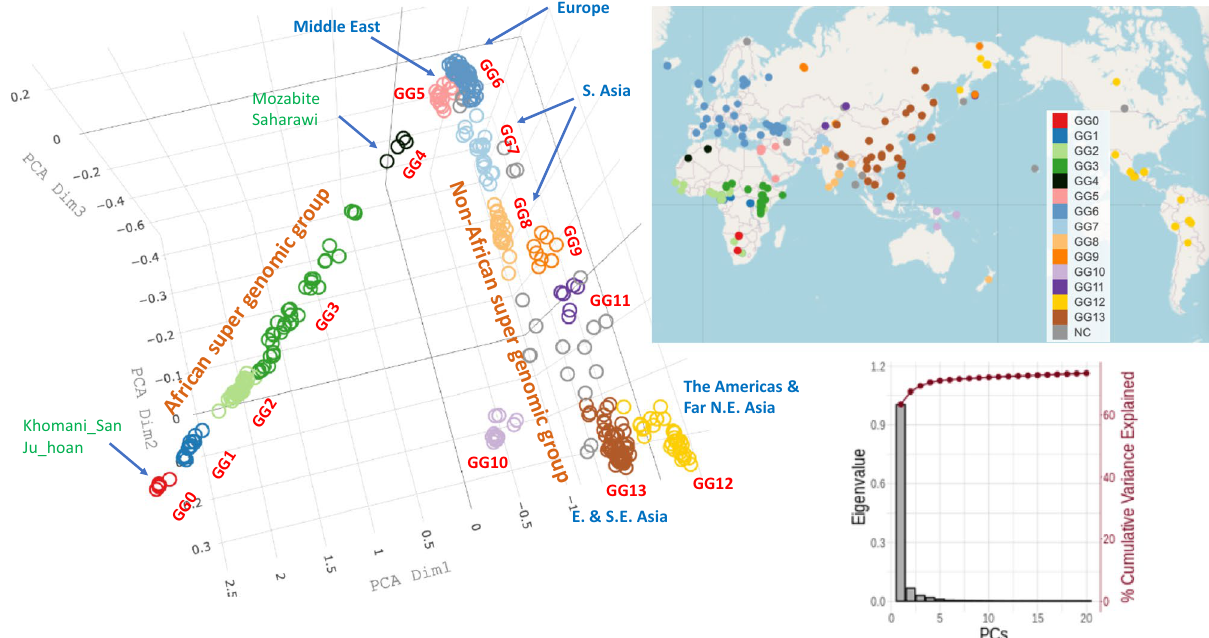
Figure 1. Clustering pattern by genomic-divergence-based PCA plotted for the three major principal component axes. PCA was performed using the “distance matrix”, where each “distance” is calculated by JS divergence between two FFPs of c-SNVs. Most of 345 individuals from 164 ethnic groups from the updated SGDP form about 14 clusters shown in different colors and labeled as genomic groups (GGs) GG0–GG13, of which most are tight clusters, but some are not, e.g., GG3 consists of multiple un-resolved clusters of African ethnic groups. All un-clustered individuals are shown as gray circles and located outside of Africa. Although the EG members of each GG are tightly clustered in genomic divergence space (PCA space), they are widely spread out within a large region bound by great geological barriers, as shown at the geographical locations of the sample collection sites, suggesting broad migration of the EGs within the region (see the top right inset). Sorted eigenvalues and variance explained in % for the first 20 principal component axes are shown in the bottom right inset. Grouping of GGs is based on a combination of the clustering pattern of individuals in PCA (in genomic divergence space), the clading pattern in NJ tree (in genomic divergence space), and the clustering pattern in geological/geographical map. A video of the rotating PCA plot is shown in Supplementary Fig.